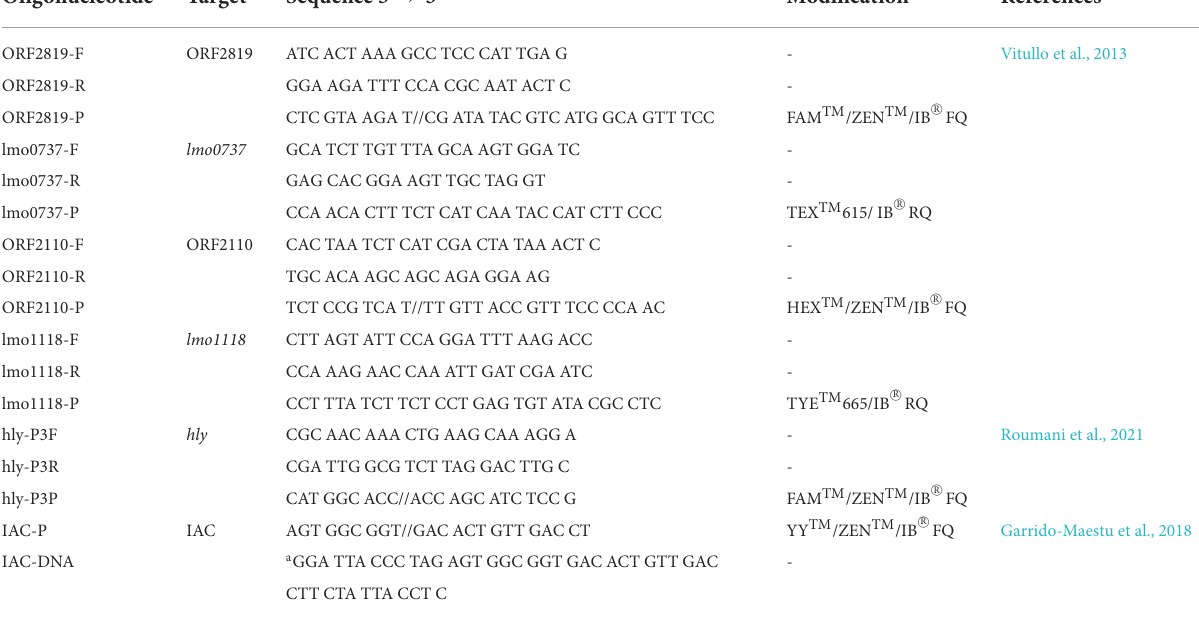
TABLE 2 Primer and probe